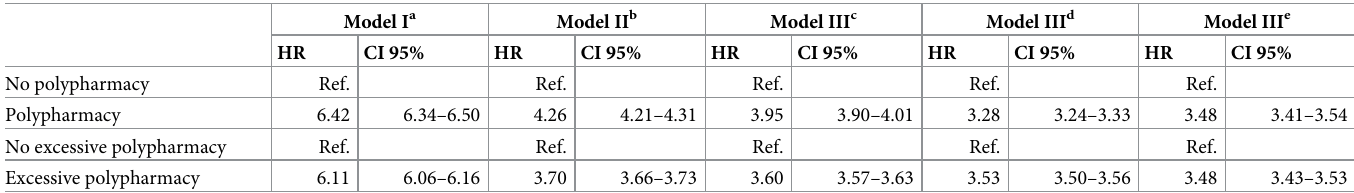
Table 5. Association between polypharmacy status and mortality among the entire population (N =